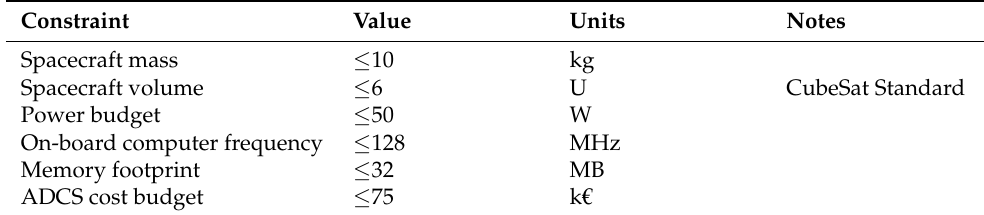
Table 1. Assumed system constraints for the proposed sensor